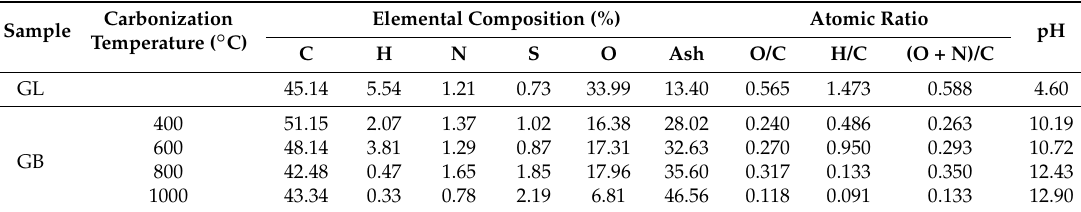
Table 1. Elemental composition of the ginkgo leaf (GL) and the ginkgo-leaf-derived biochars (GBs) produced under different carbonization